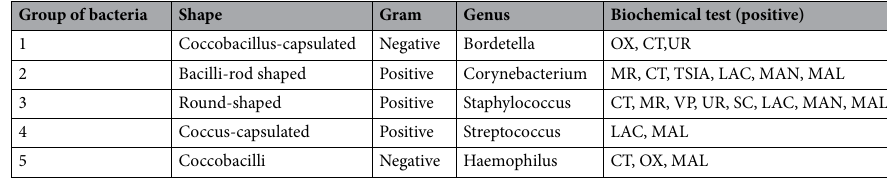
Table 2. Results of biochemical test.